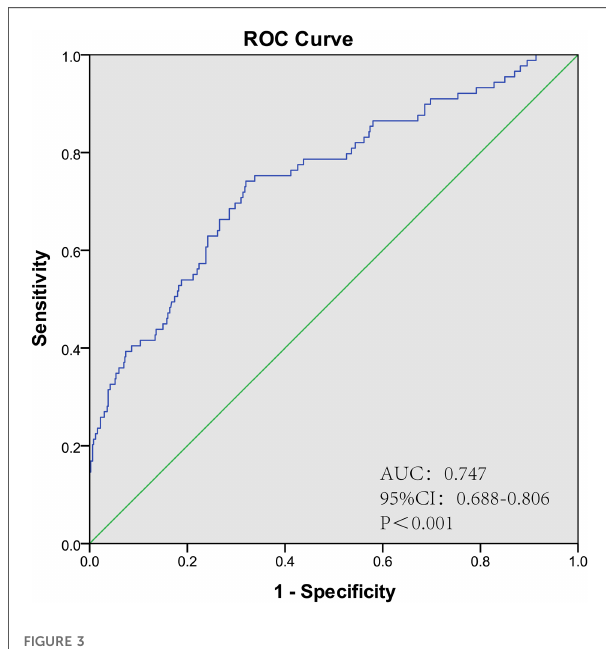
FIGURE 3 ROC curve of POAF risk prediction